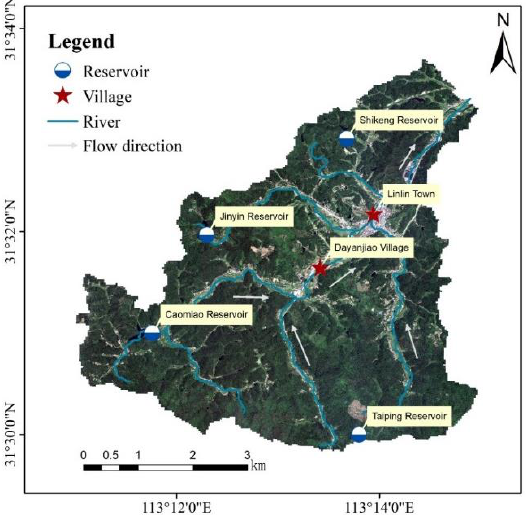
Figure 1. Distribution map of water systems and reservoirs in Liulin Town.